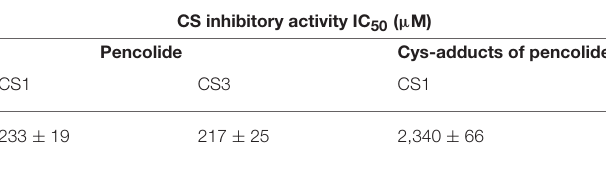
TABLE 4 | Cysteine synthase inhibitory activities of pencolide and its cysteine